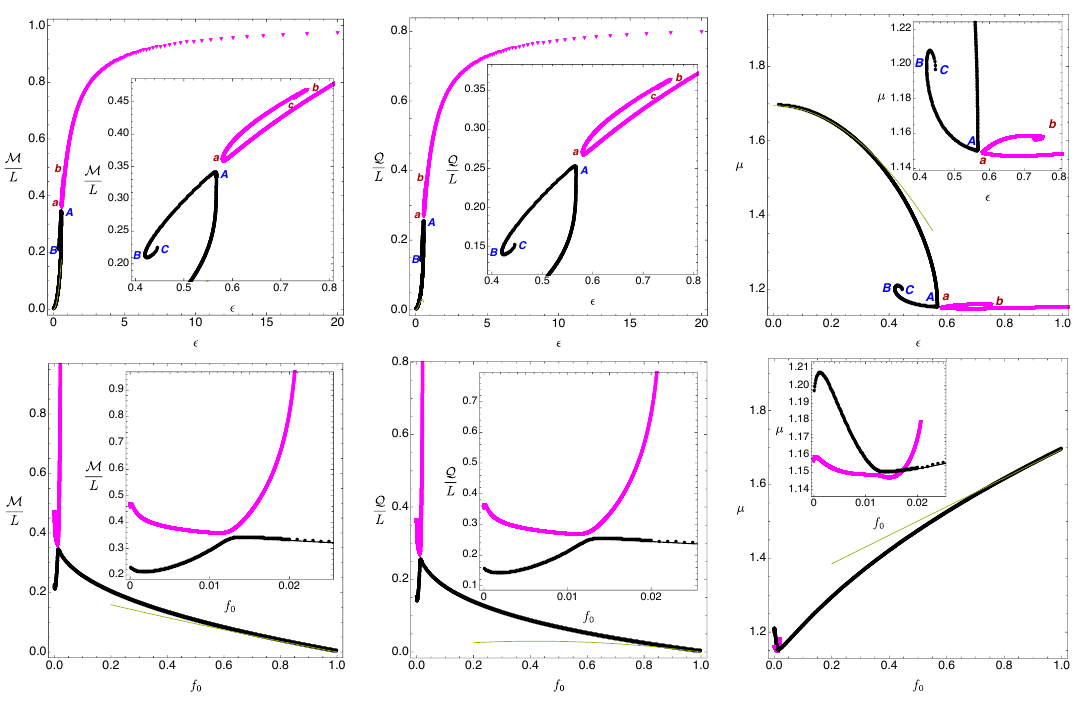
Figure 16 . Soliton families with e = 1 . 854 ( e γ < e < e c ). Top panel: the quasilocal thermodynamic quantities, namely mass, charge and chemical potential of the main (black disks) and secondary (magenta triangles) soliton families are shown as functions of the scalar field amplitude (cid:15) . Bottom panel: this time the mass, charge and chemical potential are plotted as functions of f 0 ≡ f (0) .